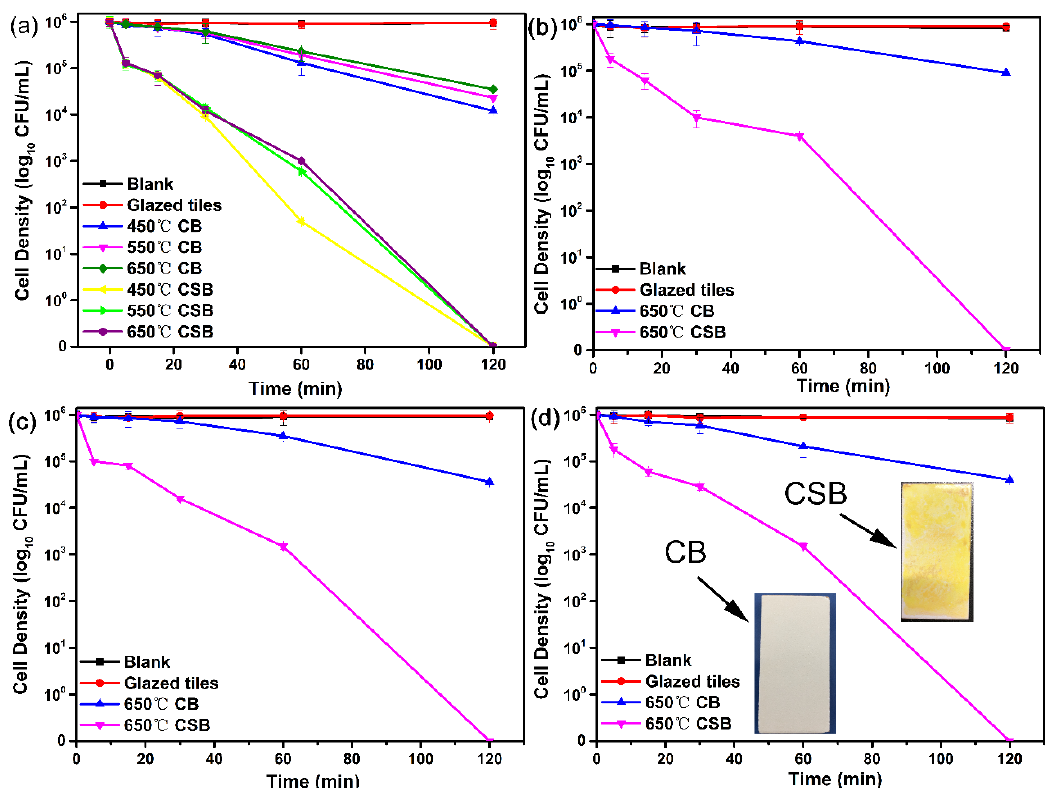
Figure 6. Escherichia coli disinfection efficiency of BiVO 4 and Ag/BiVO 4 ceramic tiles annealed at different temperatures ( a ) and ceramic tiles disinfection efficiency under different bacterial species. ( b ) Staphylococcus aureus , ( c ) Salmonella , and ( d ) Shigella (bacterial suspension concentration: 1 × 10 6 CFU/mL; common anions: 0.9% Cl −